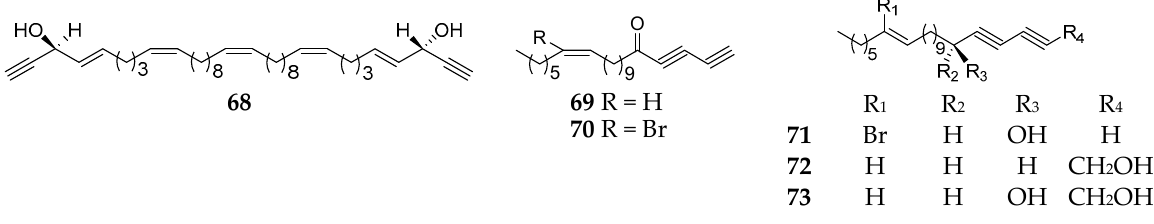
Figure 7. Aliphatic polyketides 68 – 73 from the subgenus Reniera.